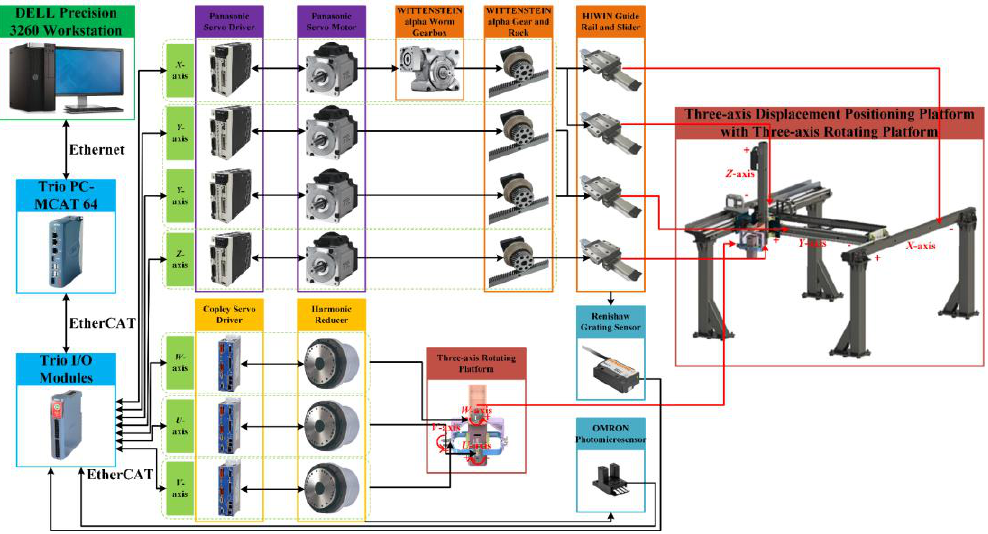
Figure 9. Overall architecture of the control system.